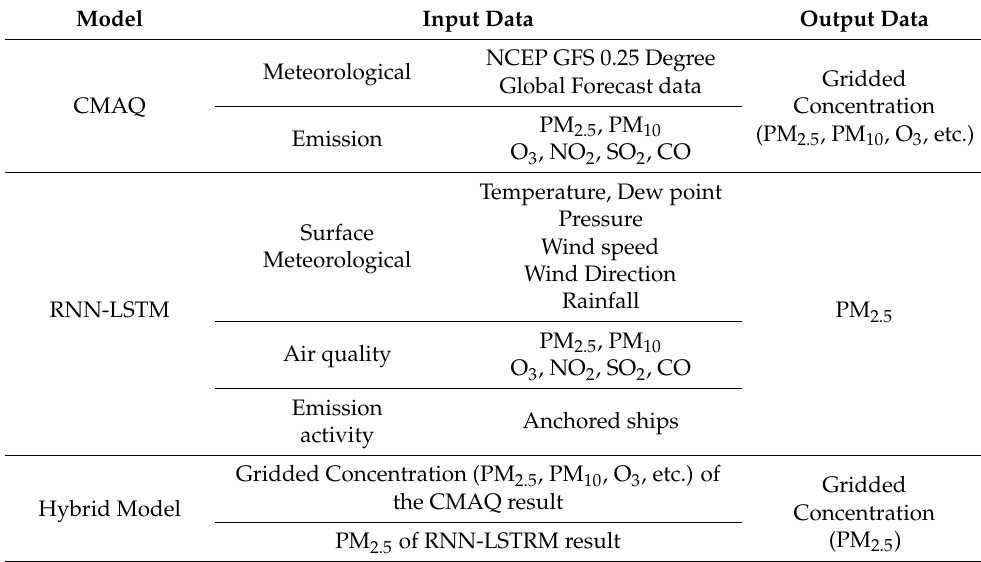
Table 2. Data types and variables of input dataset of CMAQ, LSTM, and Hybrid model.